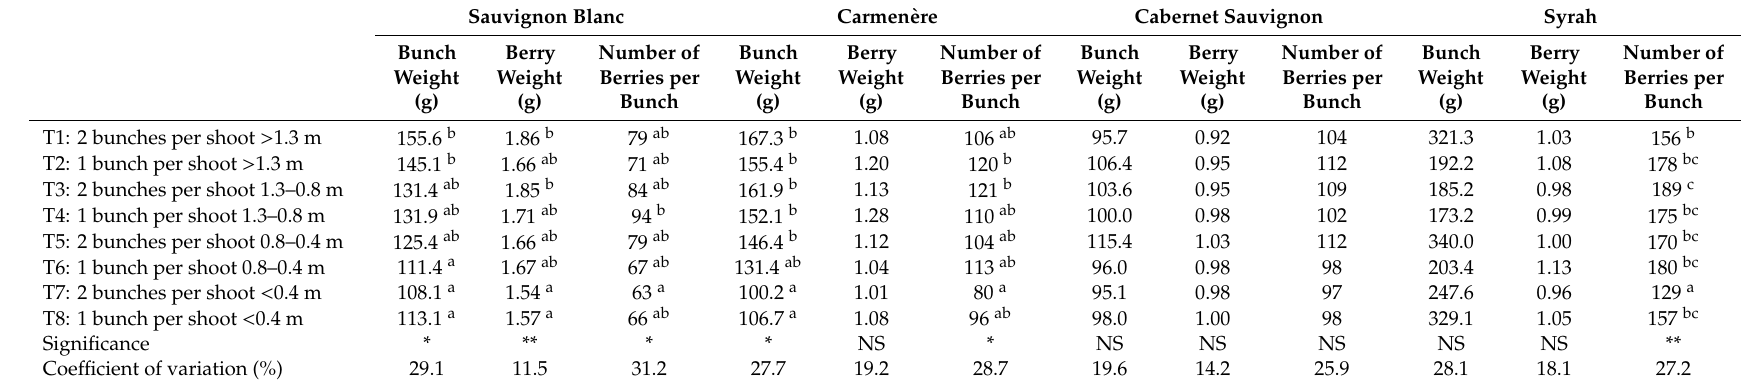
For each parameter, di ff erent letters in the same row indicate significant di ff erences among treatments (* p ≤ 0.05, ** p ≤ 0.01, NS—not